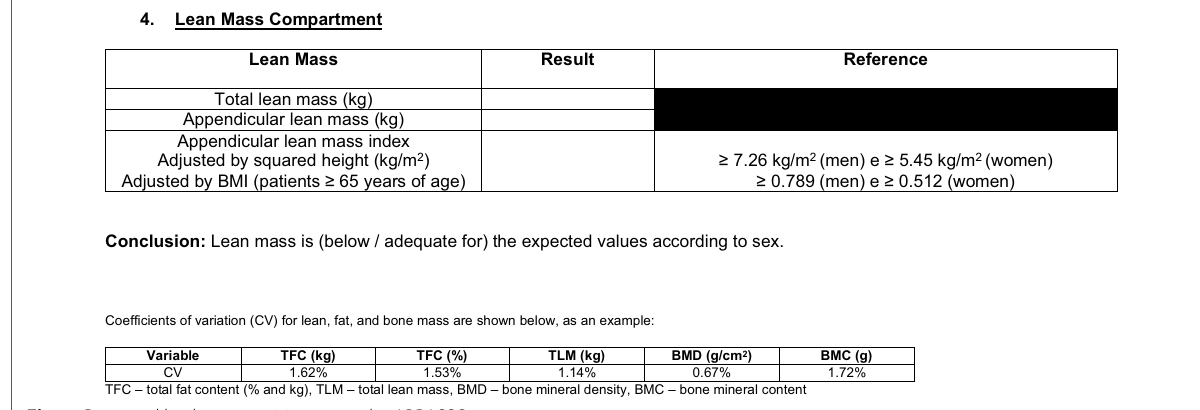
Fig. 1 Proposed body composition report by